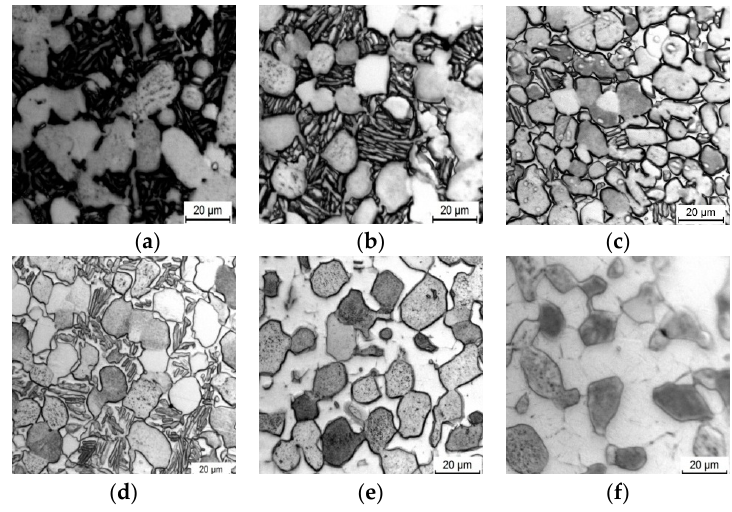
Figure 2. Optical microscopy micrographs of samples with initially microstructure I after heated up to ( a ) 700 °C; ( b ) 800 °C; ( c ) 860 °C; ( d ) 900 °C; ( e ) 940 °C and ( f ) 970 °C at 10 °C/min.